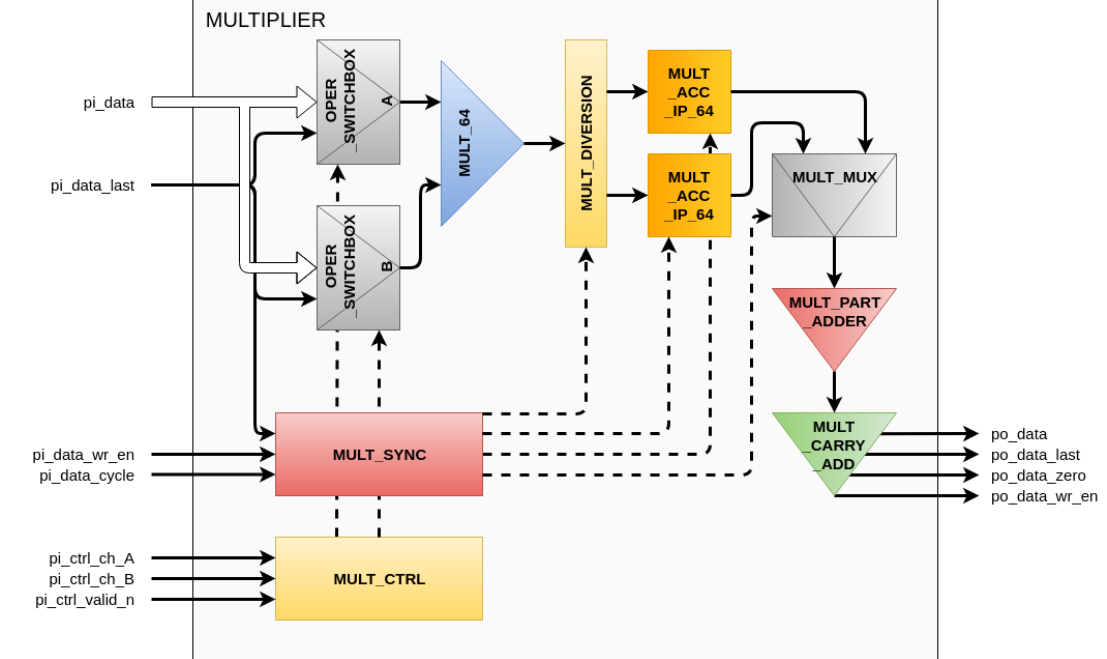
Figure 4. Block diagram of multiplier